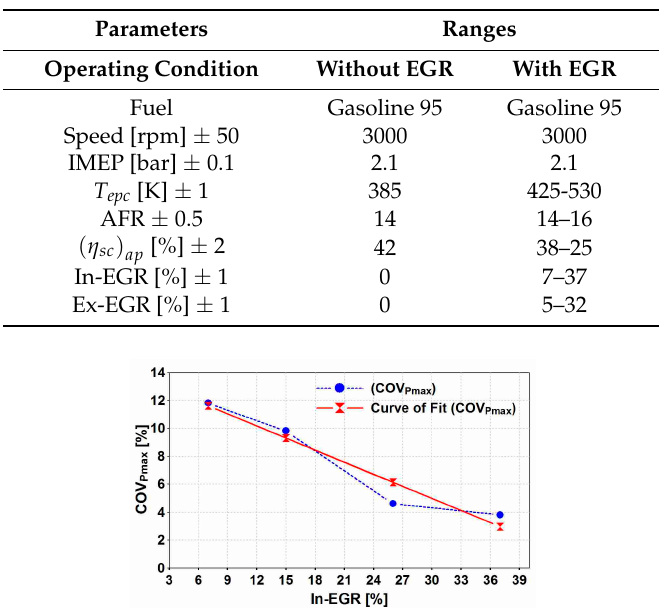
Figure 9. Cyclic variability of P max due to variation of Ex-EGR setting (rpm = 3000, IMEP = 2.1 bar, T epc = 425 – 530 K). Figures 10 and 11 represent the cyclic variability of CA10 (STD CA10 ) with respect to In-EGR and Ex- EGR variations. As illustrated in Figure 10, STD CA10 decreases when In-EGR rate increases. In contrast, STD CA10 is increased when Ex-EGR increases. Even though In-EGR improves the cyclic variability of CA10, Ex-EGR seems to deteriorate it. Correspondingly, it is thought that STD CA10 is directly proportional with percentage of Ex-EGR while it is inversely proportional with the percentage of In- EGR. Furthermore, the STD CA10 is more sensitive to Ex-EGR changes rather than In-EGR, as it can be clearly interpreted from the slope ratio of the curves of fit in Figures 10 and 11.